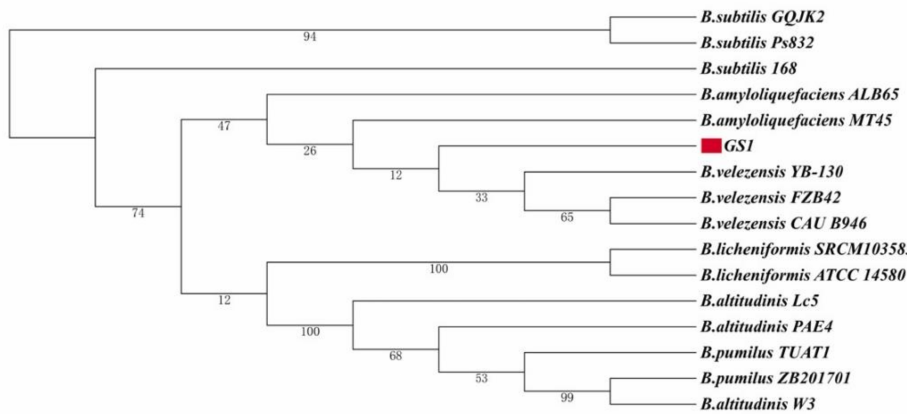
Figure 3. Phylogenetic tree of GS-1 and 15 other Bacillus species based on 16S rRNA sequence analysis. The red color indicated the strain GS-1 isolated in this